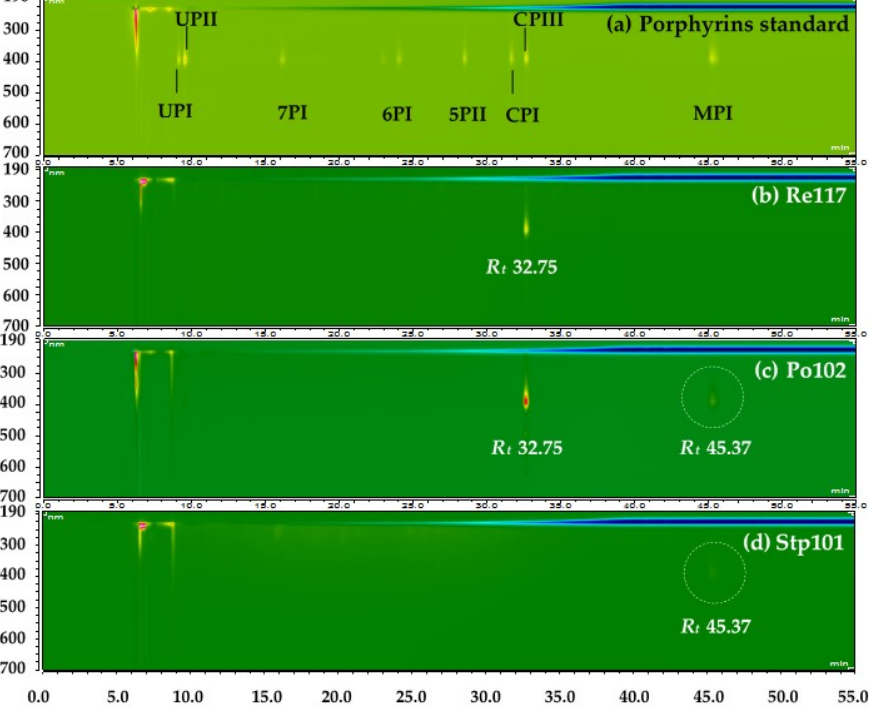
Figure 3. Fluorescent properties of porphyrin standard mixture ( a ) and red pigments extracted of G. arilaitensis strains, including ( b ) Re117, ( c ) Po102, and ( d ) Stp101.